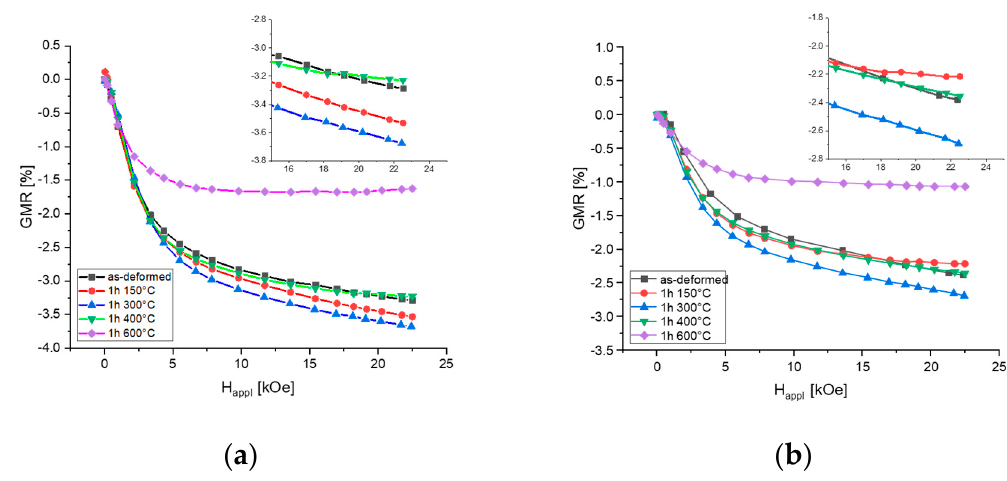
Figure 7. Drop in resistance as a function of applied magnetic field for Cu 55 Co 45 in as-deformed and different annealed states. ( a ) Current applied perpendicular to the magnetic field, ( b ) current applied parallel to the magnetic field.